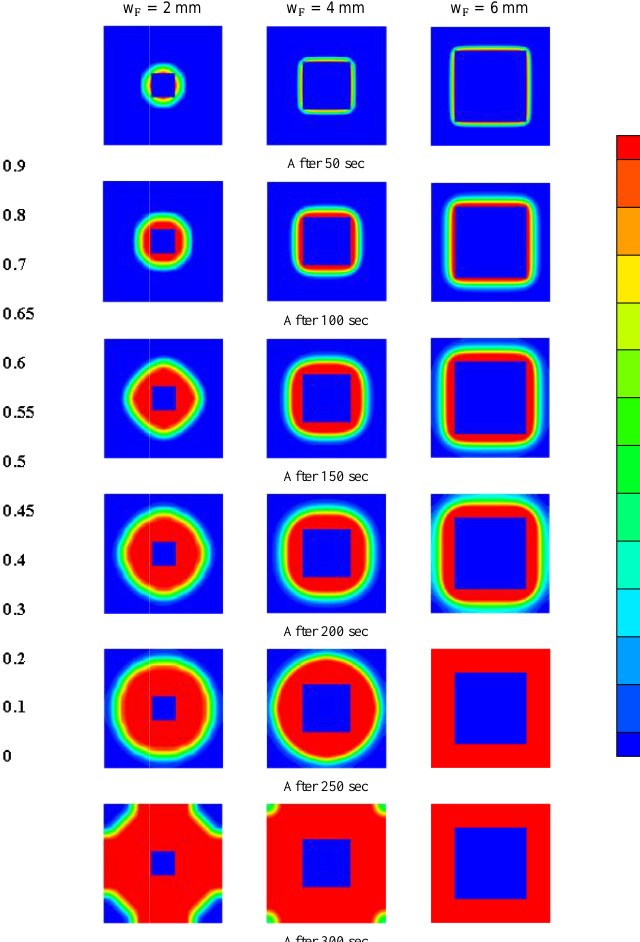
Figure 8. Melt fraction distribution for 49 fins and various fin thick- nesses.